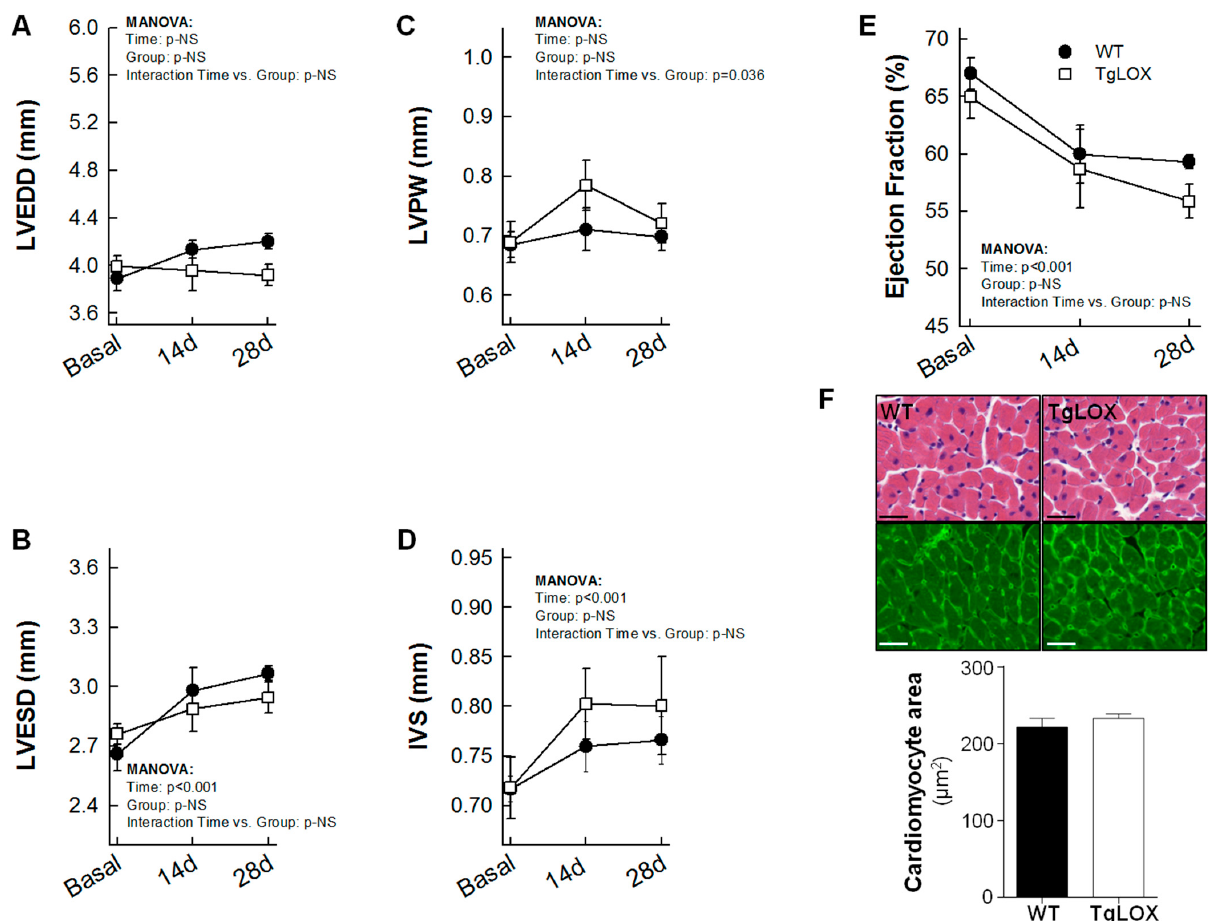
Figure 5. Changes in left ventricular end-diastolic internal diameter (LVEDD; ( A )), left ventricular end-systolic internal diameter (LVESD; ( B )), posterior wall thickness (LVPW; ( C )), interventricular septum thickness (IVS; ( D )), ejection fraction ( E ) and cardiomyocyte cross-sectional area assessed on WGA stained sections ( F ) in wild-type (WT; n = 6) and TgLOX ( n = 7) mice subjected to a brief period of coronary artery occlusion (45 min) and 28 days of reflow. Representative images of hematoxylin-eosin (upper panels) and WGA (lower panels)-stained sections are shown in ( F ) (bars: 25 μ m).